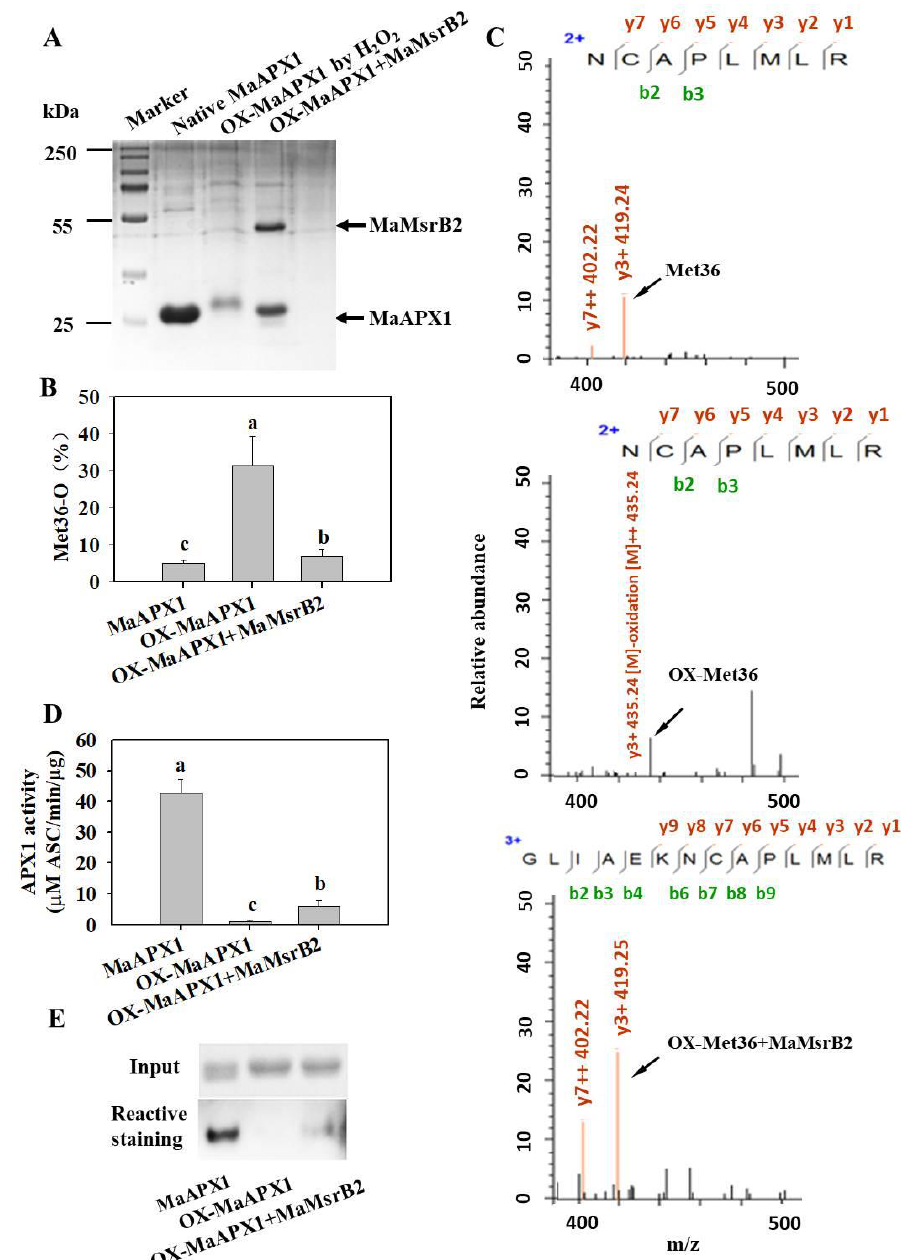
Figure 4. MaMsrB2 modifies the redox state and activity of MaAPX1. ( A ) Electrophoresis of native, oxidized, and reduced His-MaAPX1 in SDS-PAGE; ( B ) The percentage change of Met-O in the peptide containing Met36 with native, oxidized and reduced samples. Each bar represents the mean ± SE of three replicates. ( C ) Mass spectrometric analysis of the peptide containing Met36, Met36 oxidized by H 2 O 2 , and OX-Met36 reduced by MaMsrB2. ( D , E ) Activities of MaAPX1, oxidized MaAPX1, and MaMsrB2-repaired oxidized MaAPX1 by spectrophotometry ( D ) and reactive staining ( E ) methods. Different letters above the bars indicate statistically significant differences between the samples (Student’s t test; P <